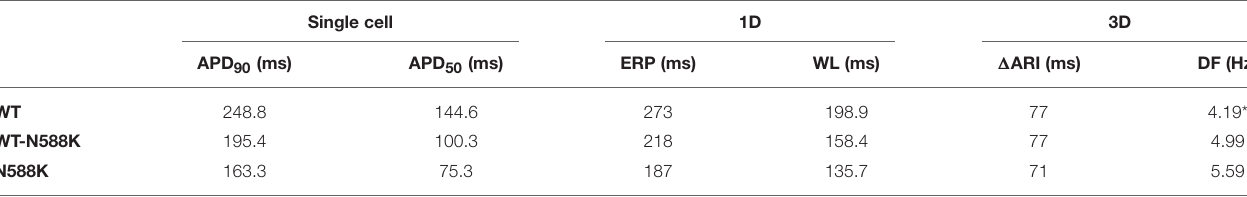
TABLE 1 | A summary of multi-scale simulation results.